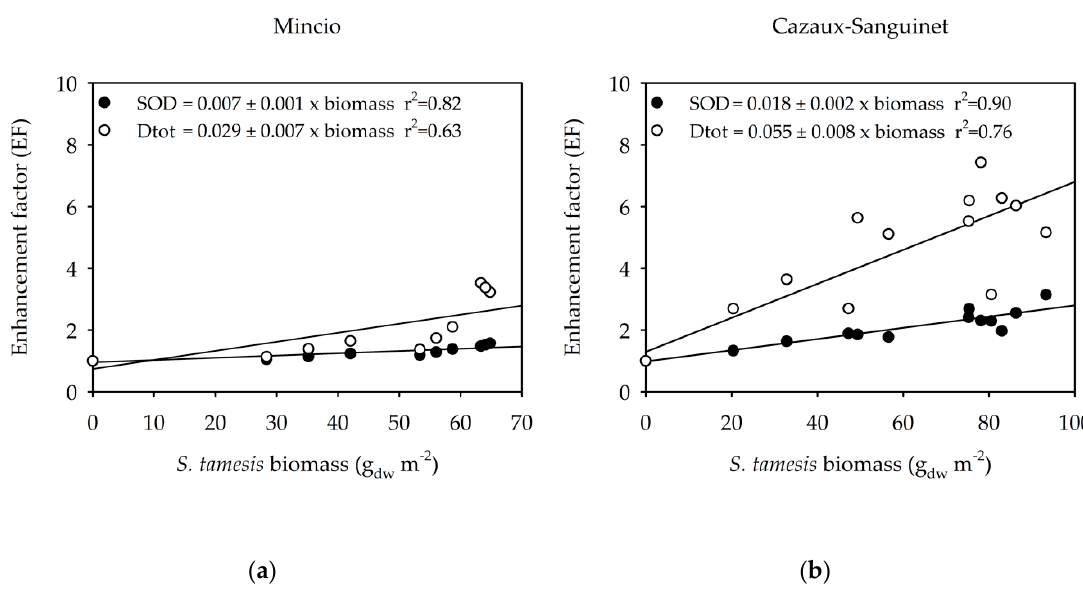
Figure 3. Enhancement factors of Sparganophilus tamesis biomass on sediment O 2 demand (SOD) and denitrification rates. Results of linear regressions are reported in the graphs. The relative stimulations were calculated by dividing the rates measured in the bioturbated sediments by the rates measured in control sediments, in the Mincio River ( a ) and in the Cazaux-Sanguinet Lake ( b ). Averages ± standard errors are reported.